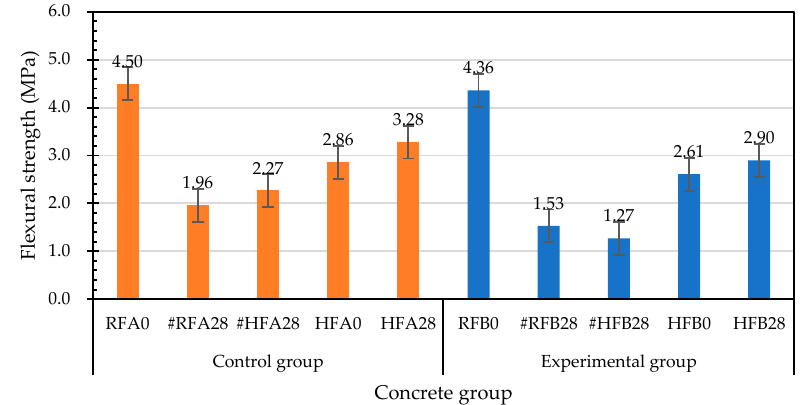
Figure 22. Effects of different test parameters on the flexural strengths of concrete.